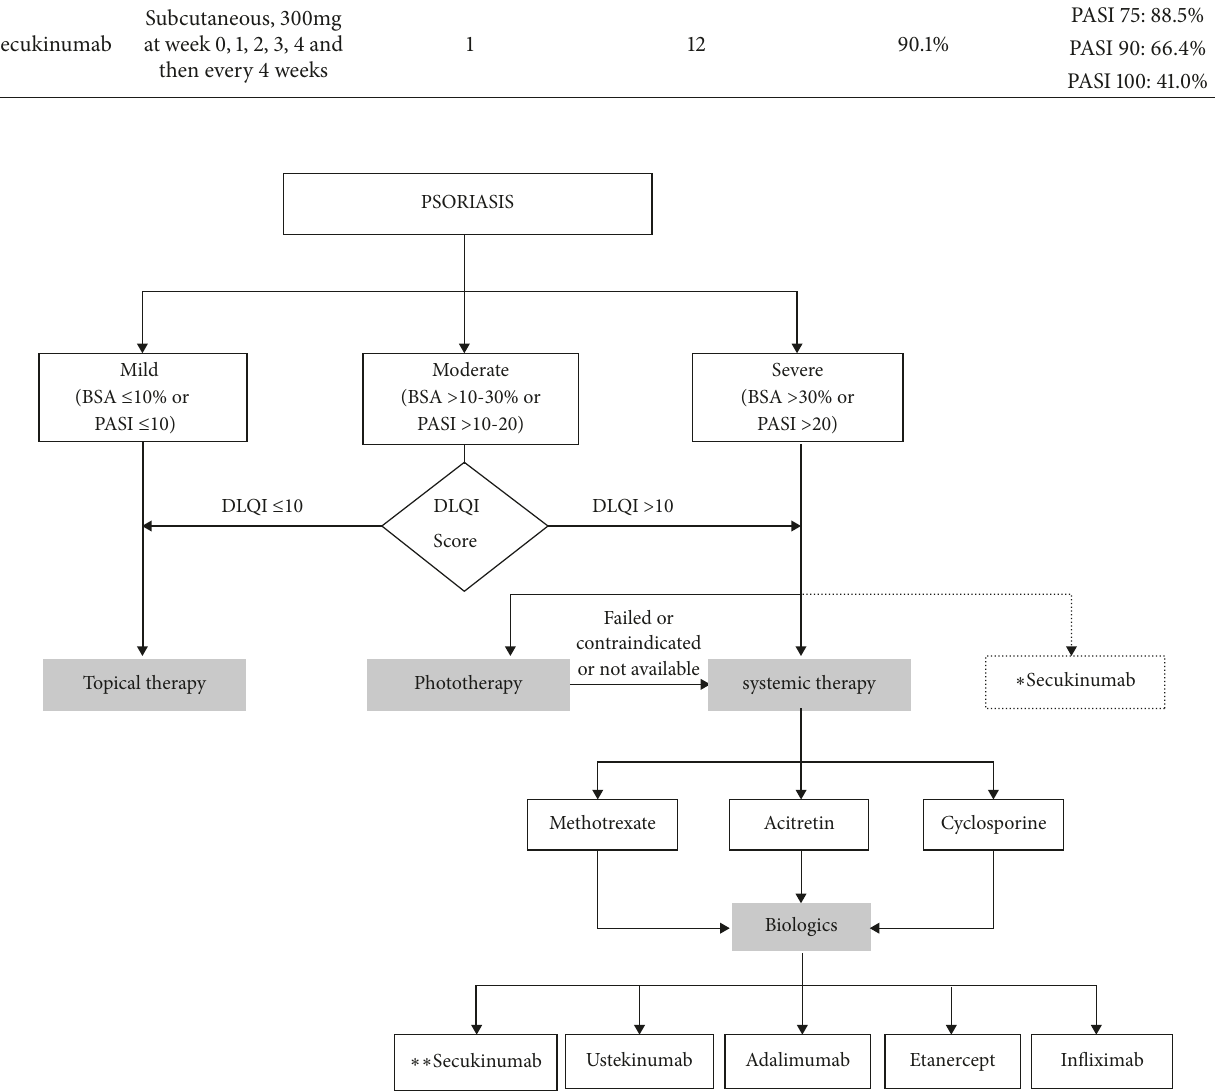
Figure 1: Psoriasis treatment flowchart and role of secukinumab according to panel members’ consensus . ∗ Secukinumab position as per indication in prescribing information. ∗∗ Secukinumab position as suggested by panel members (first line option among biologic therapies).